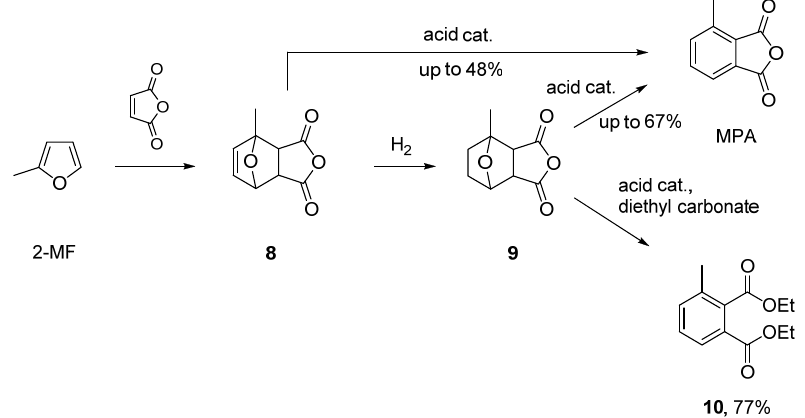
Scheme 7. Synthesis of arenes by aromatization of 2-MF-derived tricycles.